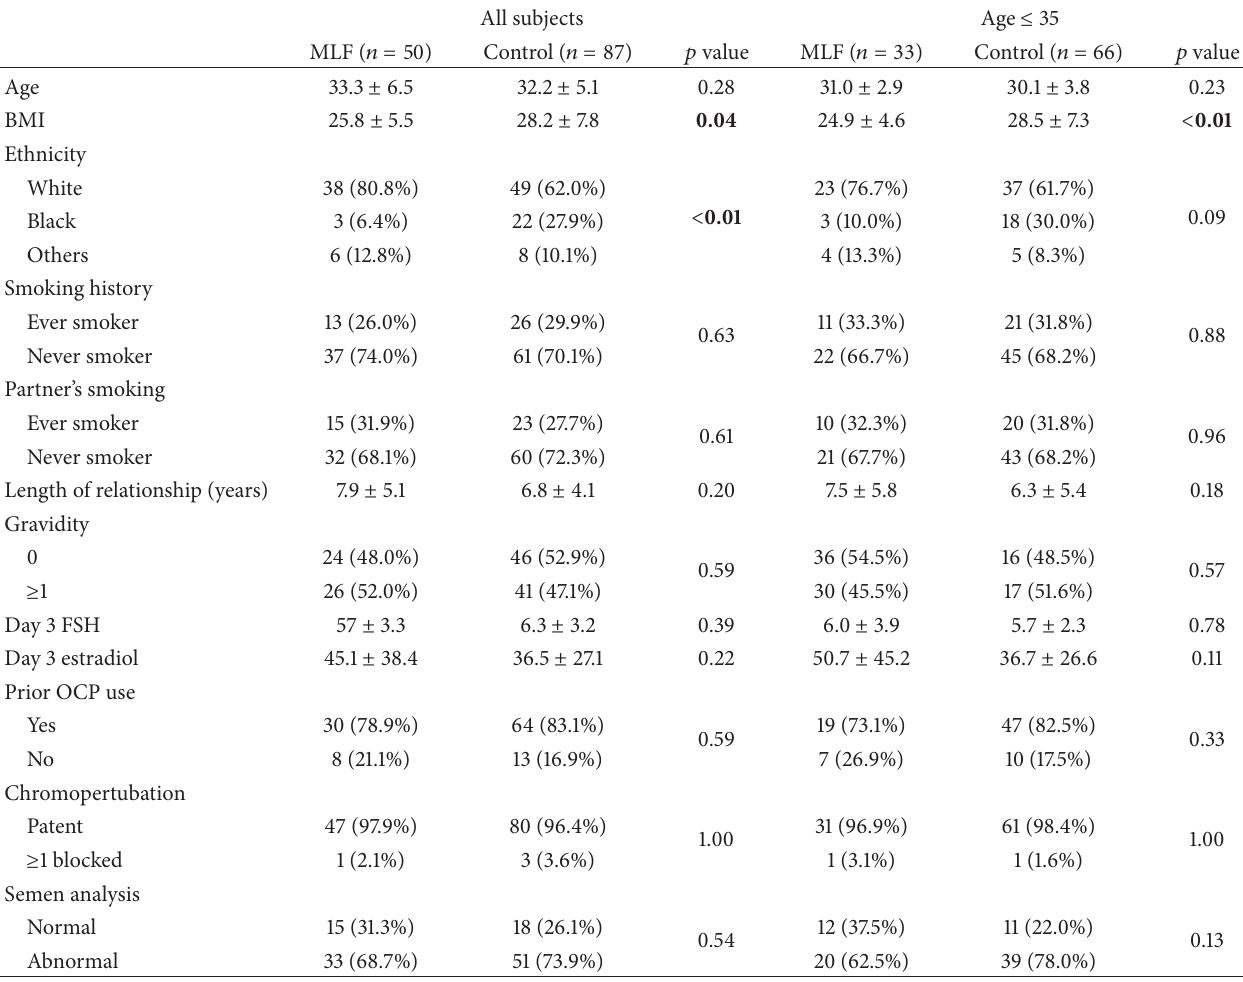
Table 1: Demographic features of all subjects.